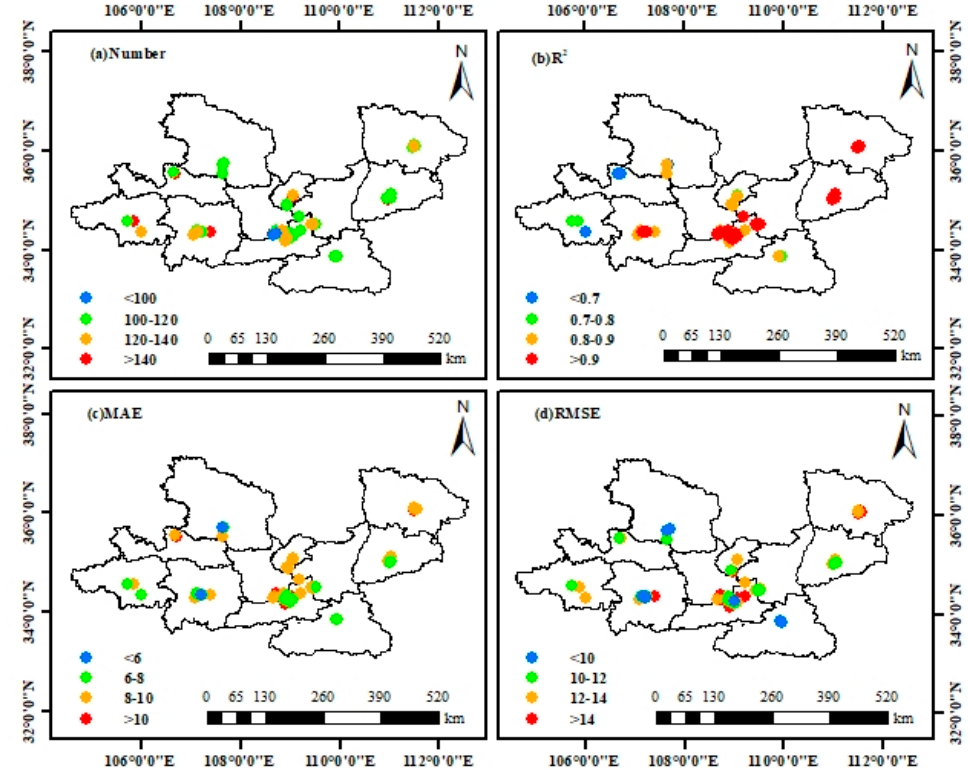
Figure 7. Spatial distributions of ( a ) the number of examined samples (N) at each monitoring station, ( b ) R 2 , ( c ) MAE ( μ g/m 3 ), and ( d ) RMSE ( μ g/m 3 ) between PM 2.5 estimations and measurements from DFM for the years of 2018–2019 in GUA.